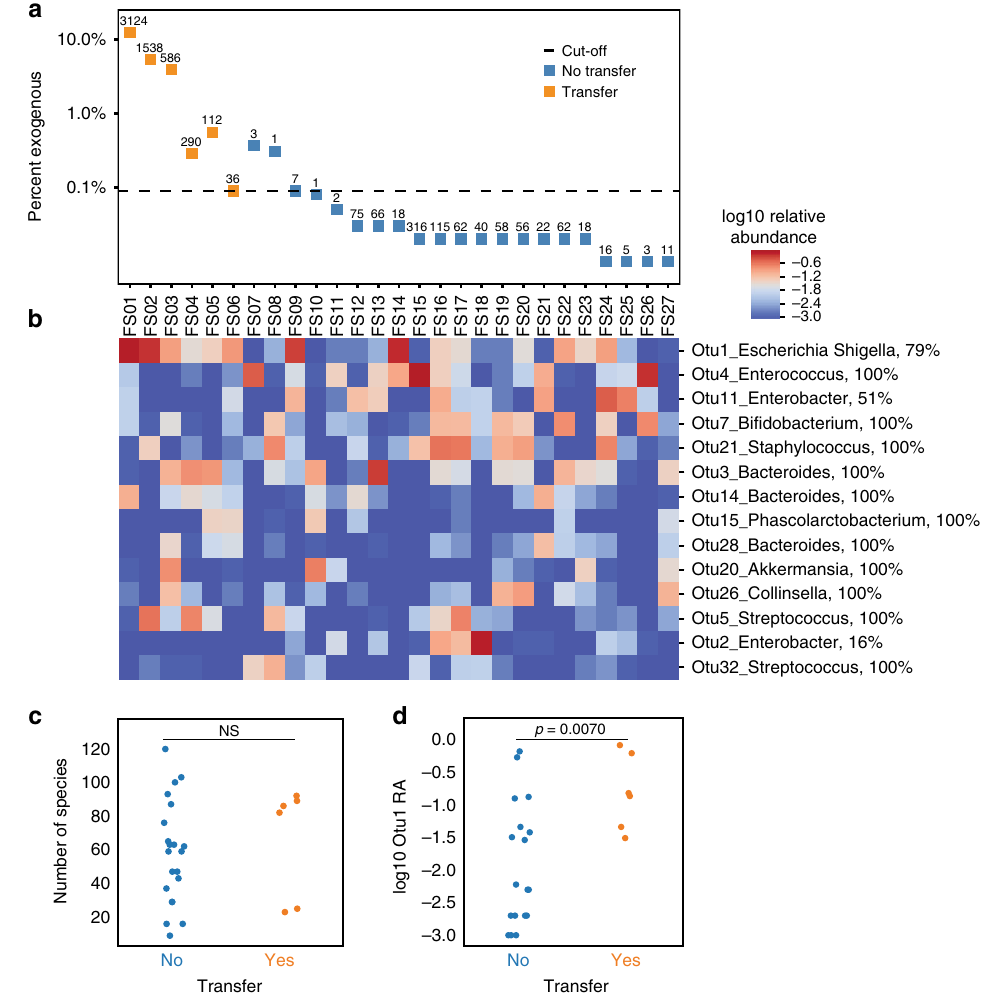
Fig. 4 Measurement of HGT events in 27 clinical fecal samples. a Identifying fecal samples with robust exogenous spacer acquisition. Percent of spacers classi fi ed as exogenous for each sample. Samples with at least 0.09% exogenous spacers (dashed threshold line) and a minimum of 10 unique exogenous spacers (denoted above each data point) were classi fi ed as samples with HGT events (orange data points). b Cluster map of 16 S operational taxonomic units (OTUs) abundance for the 27 fecal samples. Samples with observable transfer (FS01-FS06) or no observable transfer (FS07-FS27) are shown. OTUs observed at >0.05 relative abundance in at least 2 samples are shown; log10 relative abundance is displayed. For each OUT the predicted species is noted with the con fi dence of the prediction (%). c Number of unique OTUs per samples strati fi ed by transfer status. d Relative abundance of Otu1 ( Escherichia/ Shigella ) strati fi ed by transfer status. Samples with transfer have a signi fi cant higher abundance of Escherichia/Shigella ( p = 0.0070, Mann – Whitney U